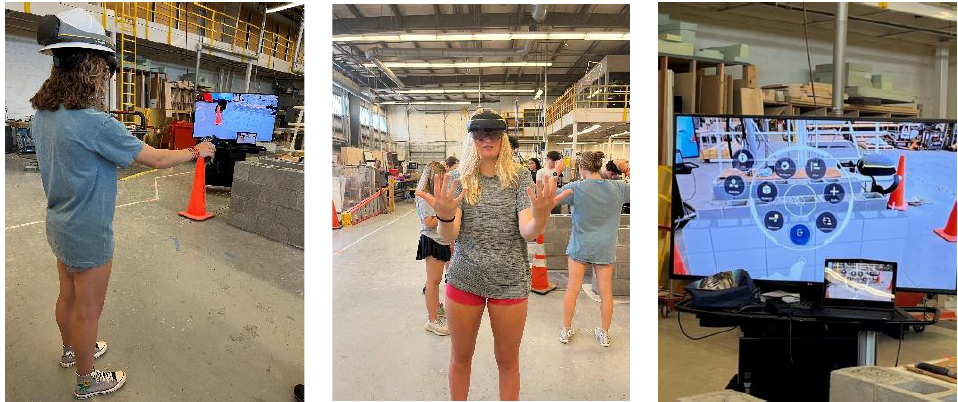
Figure 2. MR application using OHMDs where Georgia Tech summer camp students can place the Revit model of a masonry wall in front of a physical one to compare dimensions and measure both.